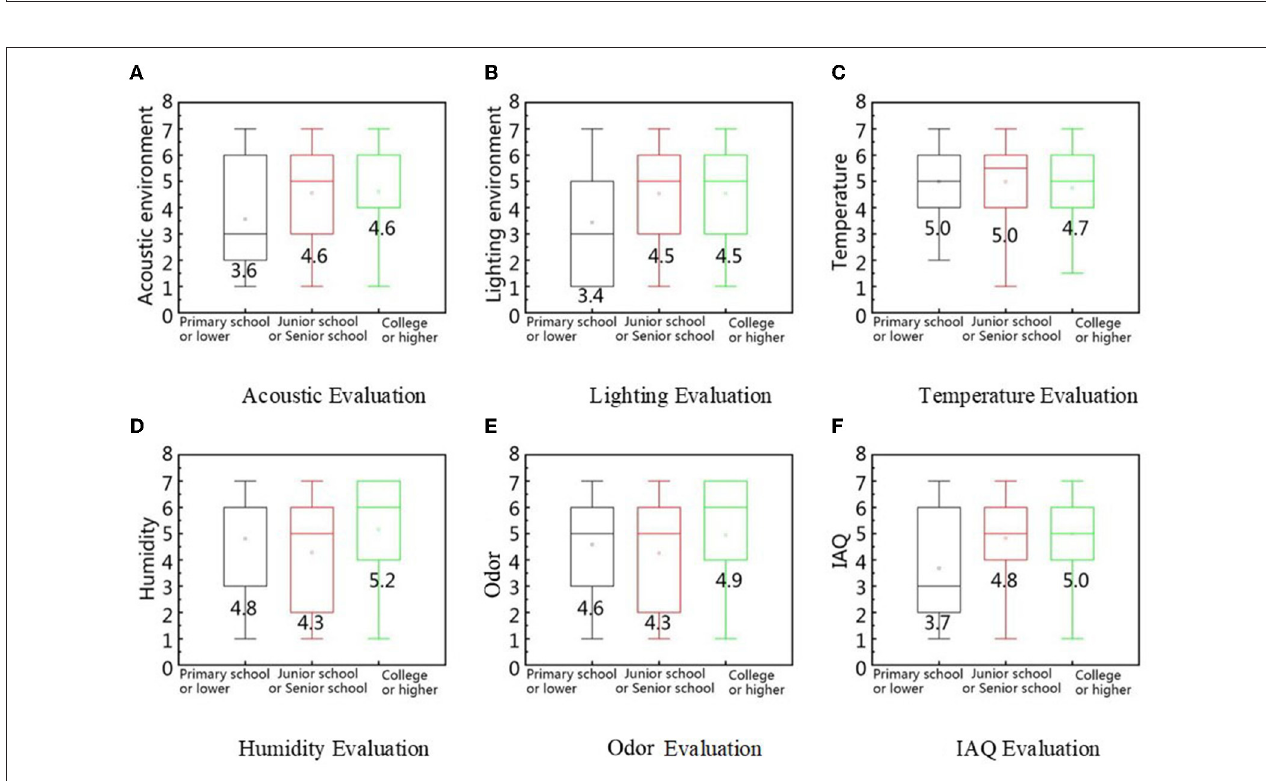
FIGURE 14 | IEQ factors evaluation based on the difference in education level. (A) Acoustic evaluation, (B) Lighting evaluation, (C) Temperature evaluation, (D) Humidity evaluation, (E) Odor evaluation, and (F) IAQ evaluation.